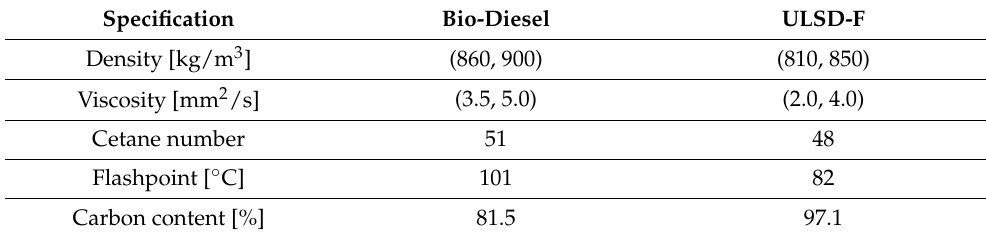
Table 3. Biodiesel and ULSD-F specifications.